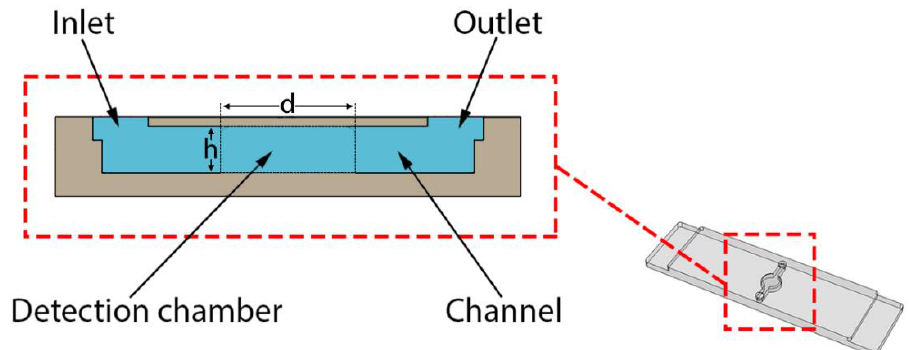
Figure 2. Cross-section of the 3D printed microfluidic device. The diameter (d) and height (h) of the detection chamber are 3 mm and 0.8 mm, respectively.